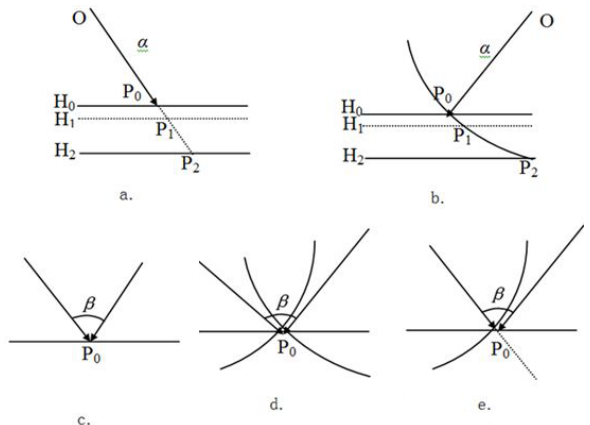
Fig 1. Relation among incidence vector, trajectory vector and FIA(a)incidence vector and trajectory vector of optical imagery;(b) incidence vector and trajectory vector of SAR imagery; (c) FIA between optical and optical images;(d) FIA between SAR and SAR images; (e) FIA between optical and SAR